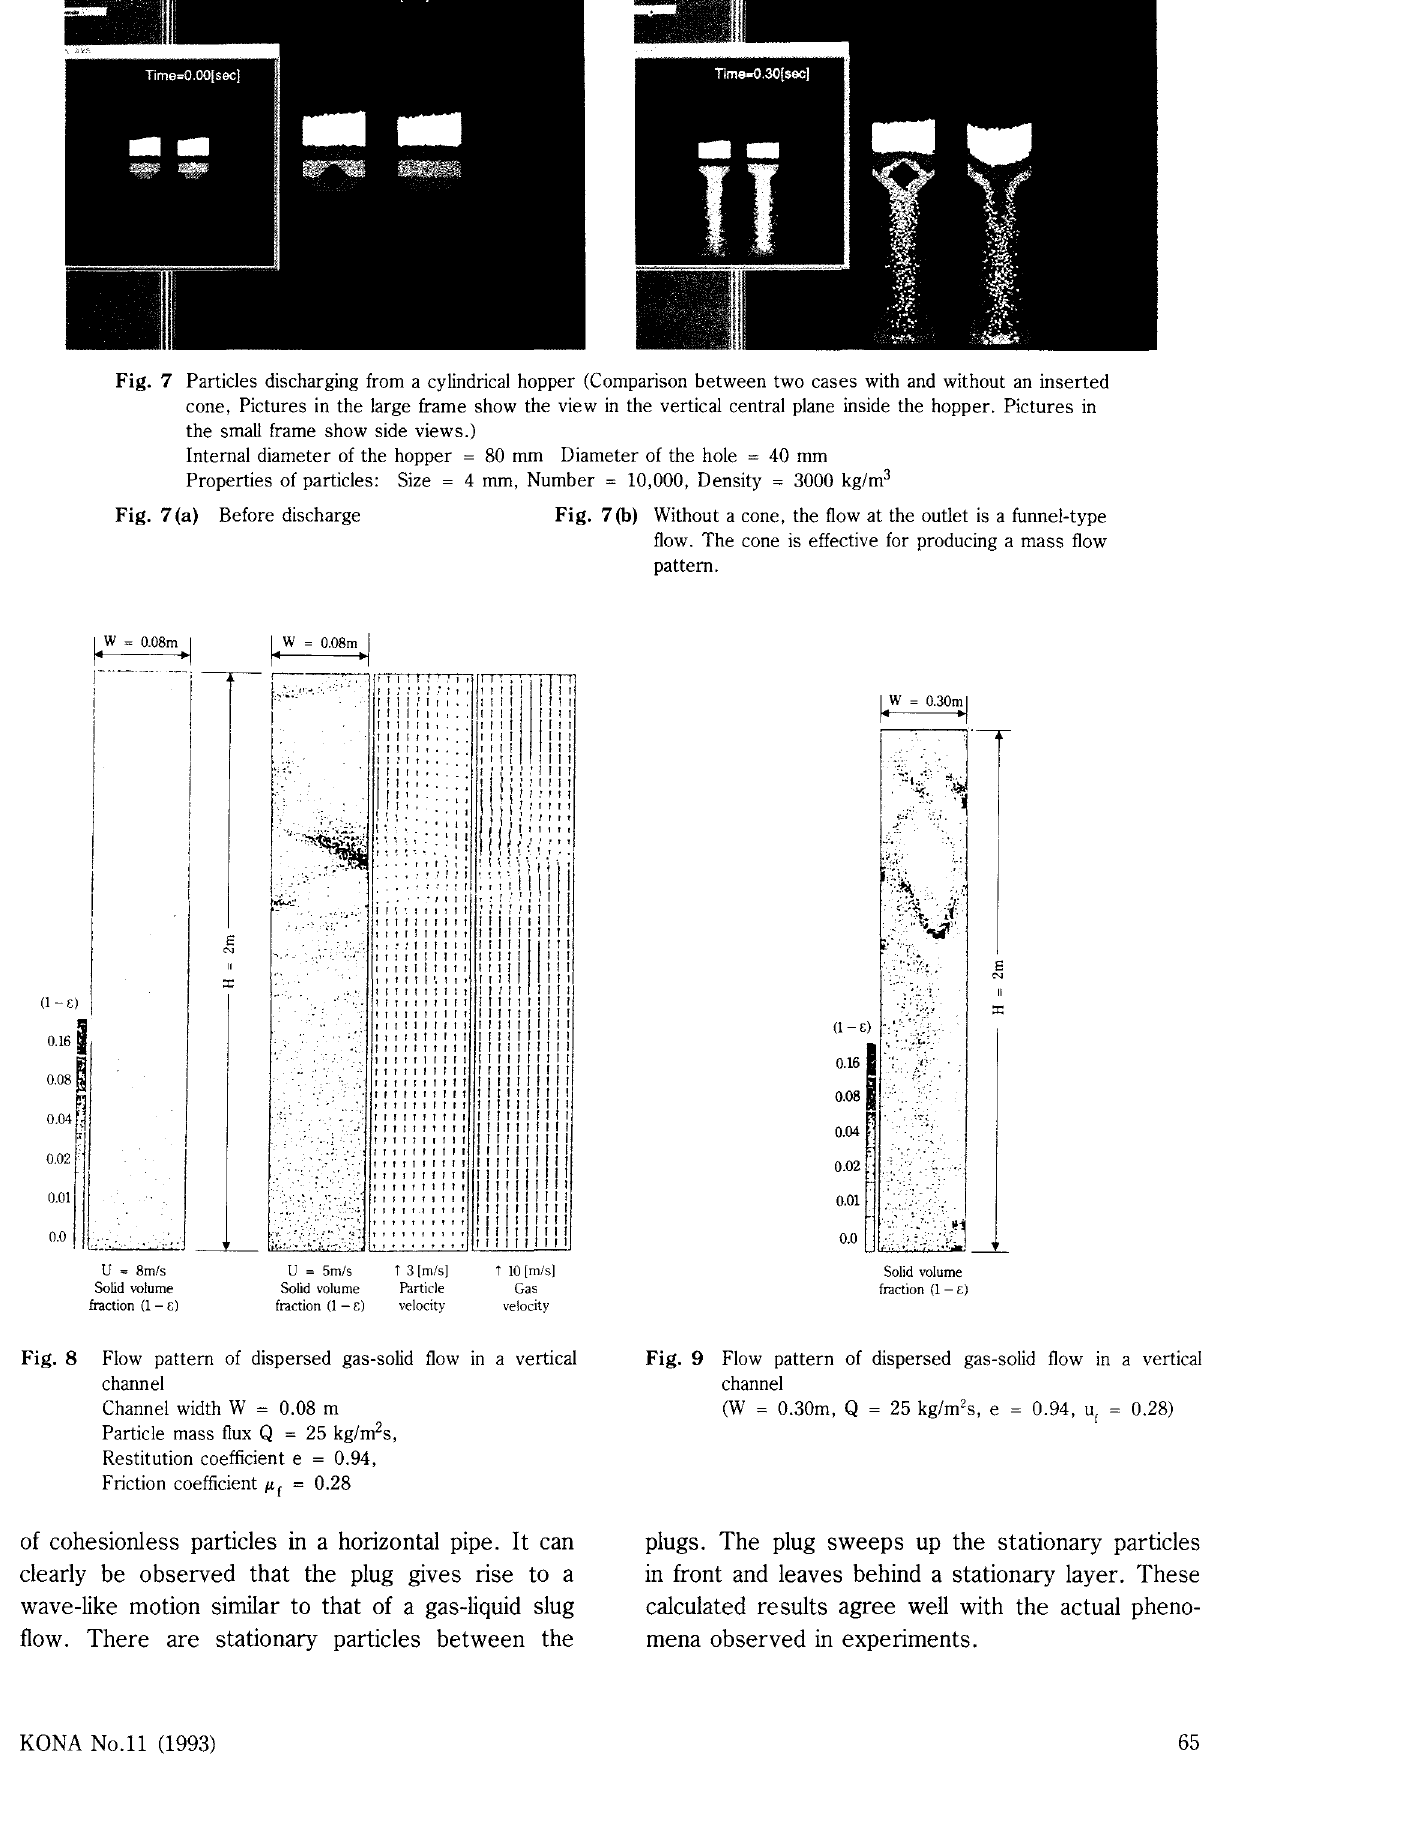
Fig. 8 Flow pattern of dispersed gas-solid flow m a vertical channel Channel width W = 0.08 m Particle mass flux Q = 25 kg/m 2 s, Restitution coefficient e = 0.94, Friction coefficient fl.c =